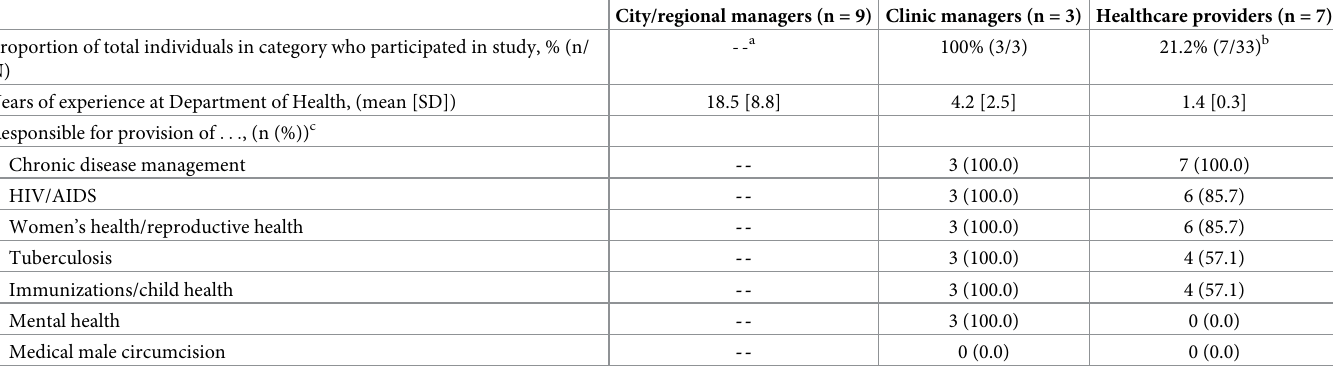
Table 1. Characteristics of study participants and responsibilities for health services provision in an administrative region of Johannesburg, South Africa (n = 19). Proportion of total individuals in category who participated in study, % (n/